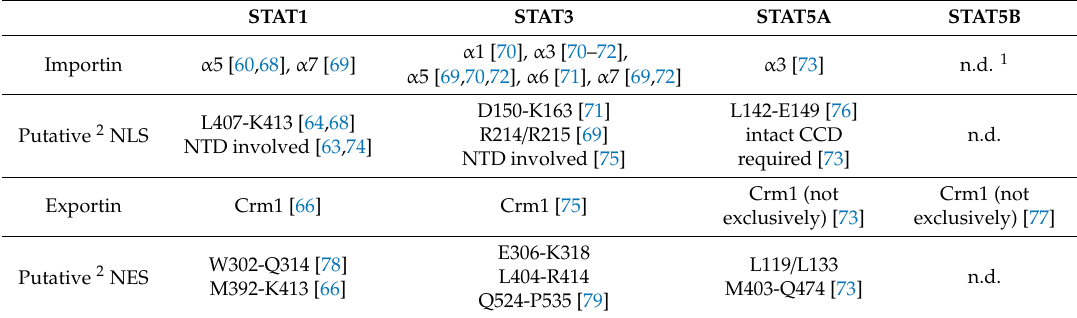
Figure 1. Structures of STAT proteins with putative nuclear localization signals (NLS) and nuclear export signals (NES) highlighted as listed in Table 1. In this context, “putative” means that the corresponding sequences do not fulfill classical NLS or NES functions but are required for nuclear transport or interaction with nuclear transport receptors. ( a ) General scheme of structural domains of STAT proteins (NTD, N-terminal domain; CCD coiled-coil domain; DBD, DNA-binding domain; LD, linker domain; SD, SH2 domain; TAD, transactivation domain). Numbers refer to amino acid positions. ( b – d ) Structures of individual STAT proteins as ribbon representations (left) or space-filling representations (middle and right). Domains are stained according to the coloring of the scheme in ( a ), DNA is shown in pink. Putative NLS and NES are marked in red and cyan, respectively. The corresponding references are listed in Table 1. PDB IDs: STAT1, 1BF5; STAT3, 1BG1; STAT5A, 1Y1U. Images of structures were generated with PyMOL. Table 1. NTRs, NLS and NES involved in transport of STAT proteins.